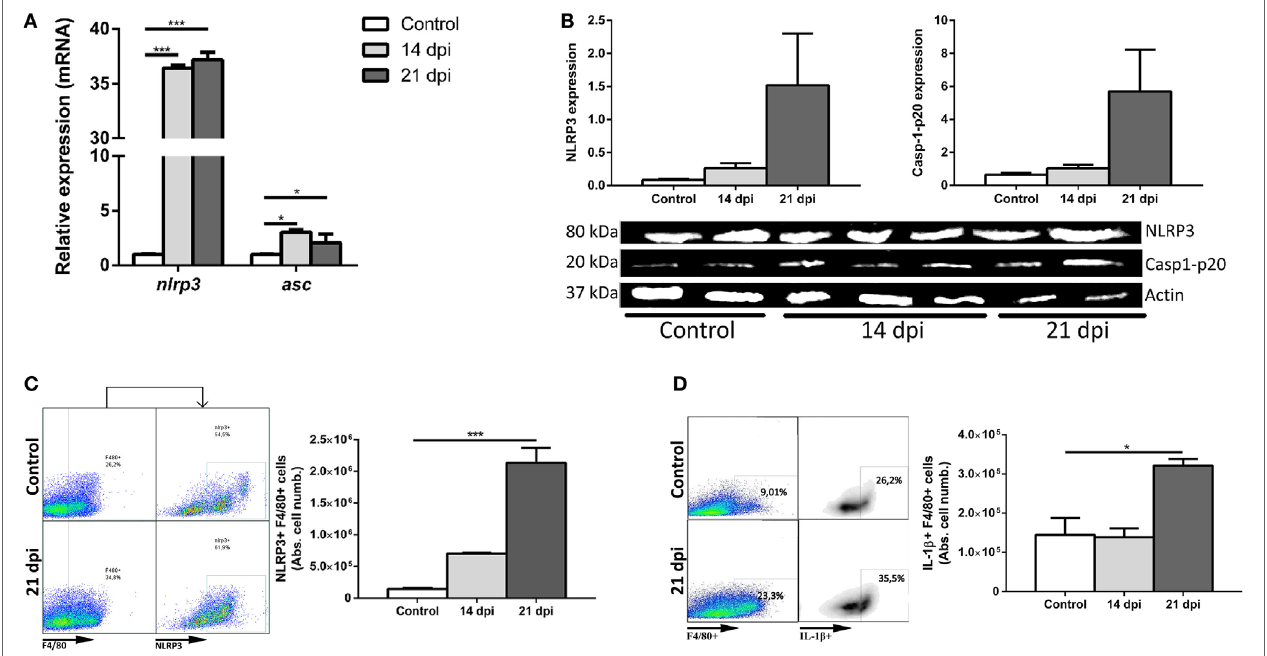
FigUre 1 | Trypanosoma cruzi triggers NLRP3 inflammasome response in the liver of wild type (WT) mice. Male WT mice were intraperitoneally inoculated with 10 3 trypomastigotes-Tulahuen strain and livers were collected and perfused at 14 and 21 days post infection (dpi). (a) Hepatic transcript levels of nlrp3 and asc . (B) Cropped lanes of protein expression of NLRP3 and caspase-1-p20 active subunit of liver samples assessed by Western blotting (uninfected controls, n = 2; 14 dpi, n = 3; 21 dpi, and n = 2). (c) Representative dot plots and absolute number of hepatic NLRP3-expressing F4/80 + cells. (D) Representative dot plots and absolute number of IL-1 β -producing F4/80 + cells. Gate strategies (Figure S1A in Supplementary Material) were performed using anti-F4/80 + and anti-NLRP3 plus A633-anti-goat fluorochrome-labeled antibodies. Data are shown as mean ± SEM from one of three representative experiments; n = 2–6 mice per group. Statistical significance was evaluated by Two-way ANOVA followed by Bonferroni post hoc test. * p < 0.05; ** p < 0.01; *** p <